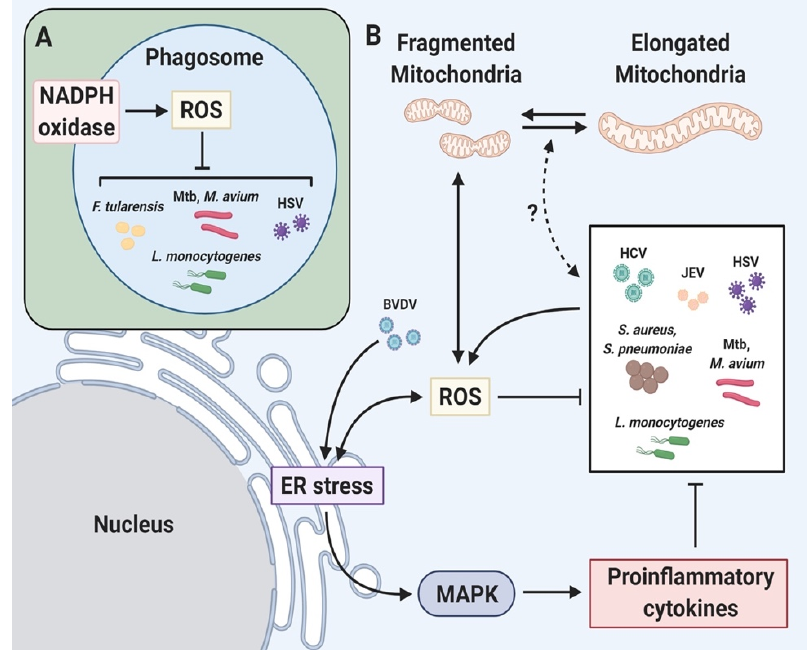
Figure 4. Relationship between ROS and pathogens. Pathogen elimination via ROS-mediated immune signaling. ( A ) Pathogens are recognized by PRRs, phagocytized and digested. NOX is assembled and activated to produce ROS in the phagosomal membrane, resulting in elimination of the pathogen. ( B ) ER stress and mitochondrial fragmentation induce ROS production. ROS-induced ER stress boosts proinflammatory cytokine production via MAPK, resulting in microbial killing. Illustration of pathogen-mediated regulation of immune signaling via ROS production. HCV, hepatitis C virus; JEV, Japanese encephalitis virus; HSV, herpes simplex virus 1; BVDV, bovine viral diarrhea virus; S, aureus , Staphylococcus aureus ; S. pneumoniae Streptococcus pneumoniae ; M. tuberculosis , Mycobacterium tuberculosis ; M. avium, Mycobacterium avium ; L. monocytogenes, Listeria monocytogenes ; F. tularensis, Francisella tularensis. (Created with BioRender.com accessed on 29 March 2021).